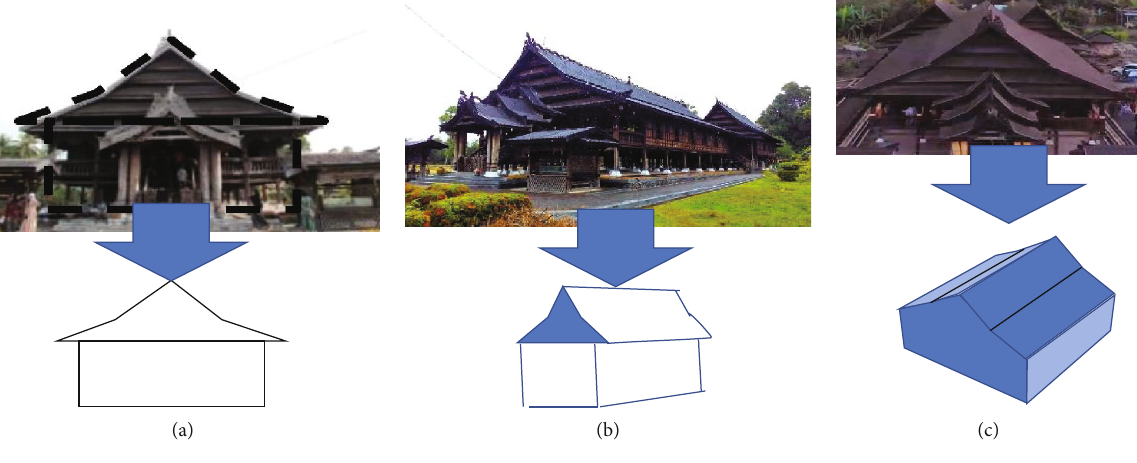
Figure 21: Mario house.